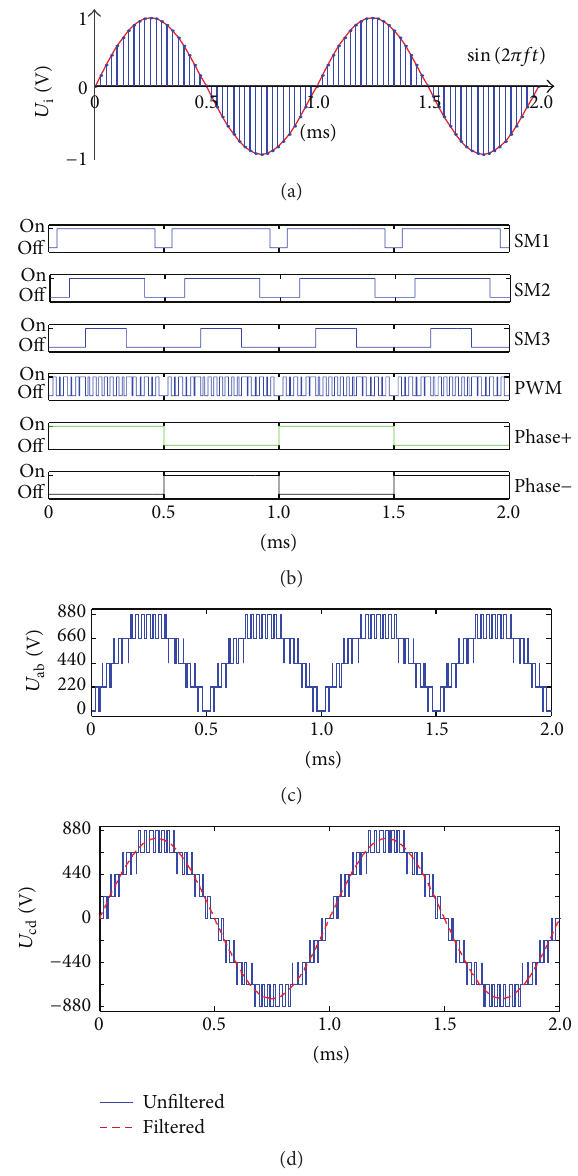
Figure 4: Simulation of switching power amplifier. (a) Sampled input signal, (b) switching signals for power converters and full bridge, and ((c) and (d)) voltage waveforms measured between a- b and c-d points, respectively (points a-d marked in Figure